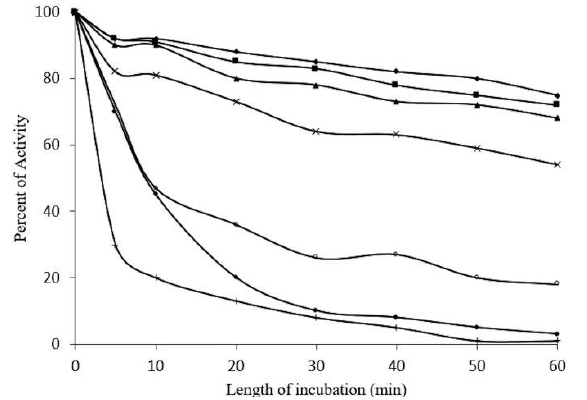
Figure 6. Effect of different temperatures on the activity of the purified β -glucosidase in Sechium edule. Maximum activity was observed at 50 °C, and a complete depletion of activity from 60 to 70 °C.